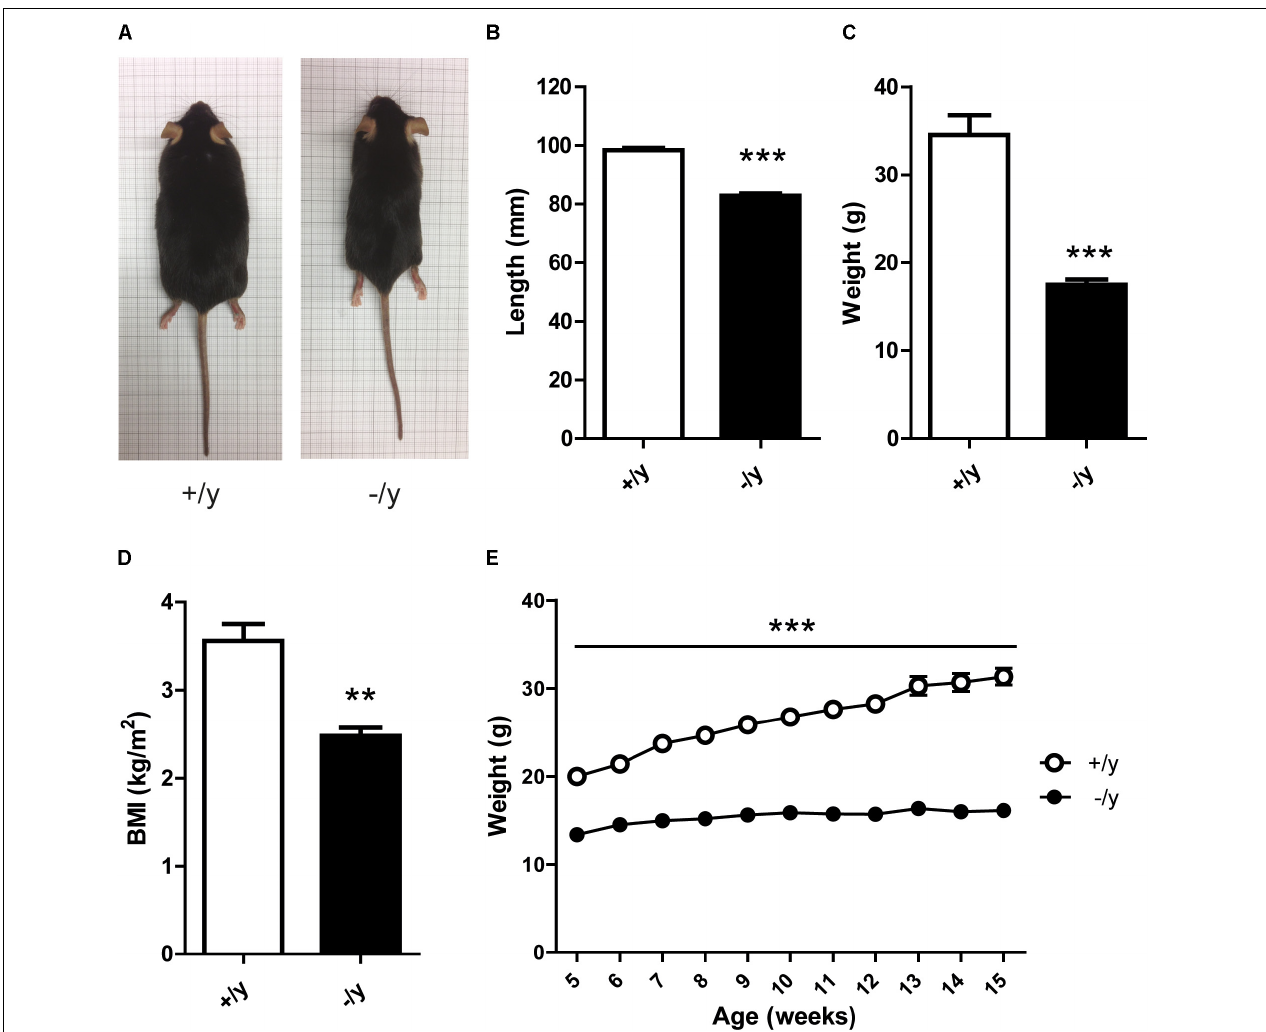
FIGURE 3 | Morphometric parameters of CT1-deficient mice. Representative body morphology (A) , snout-anus length (B) , weight (C) , and BMI (D) of 15-week-old CT1 + / y and CT1 − / y male littermates ( n = 5–6). (E) Body weight development in male animals until 15 weeks of age ( n = 9–15) ( ∗∗ P < 0.01; ∗∗∗ P <